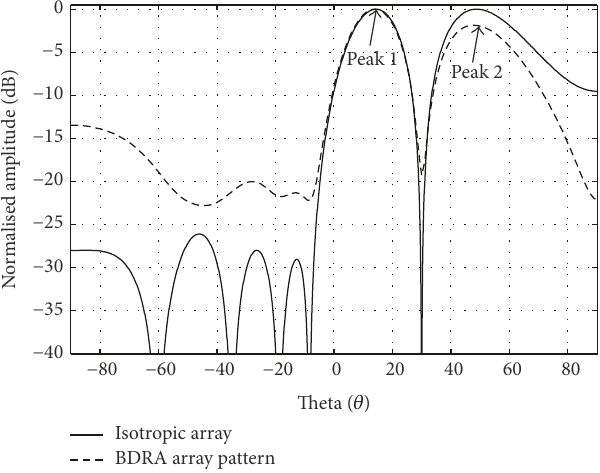
Figure 4: Comparison of coupled BDRA array (Equation (4)) and isotropic array patterns for Bayliss distribution with target SLL = − 30 dB and 𝑛 = 3 scanned to 30 ∘